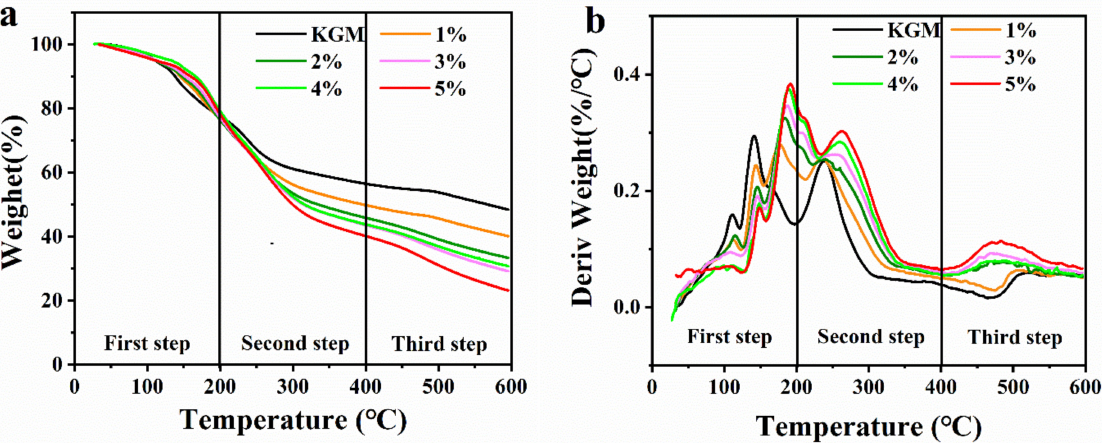
Figure 9. Thermogravimetric analysis (TGA) of samples ( a ); differential thermogravimetric (DTG) of samples ( b